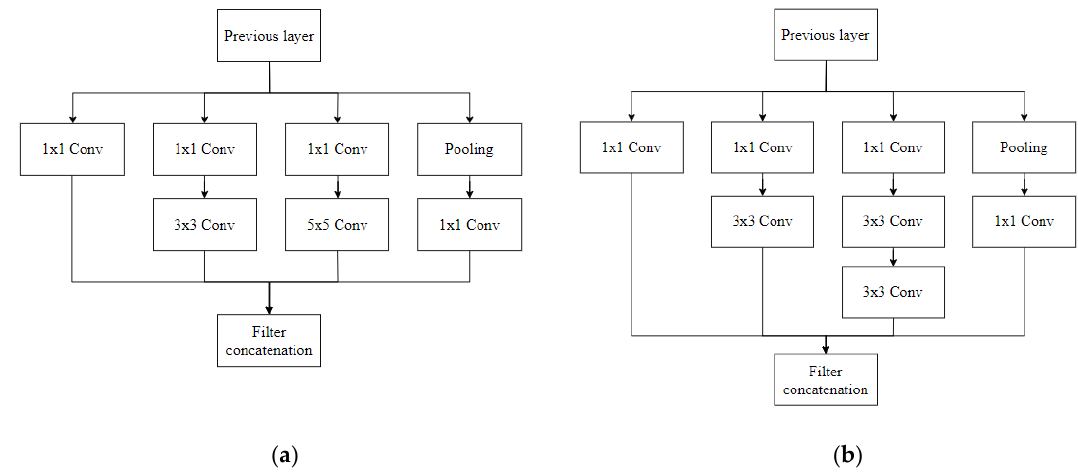
Figure 8. Inception blocks. ( a ) InceptionV1. ( b ) InceptionV3.